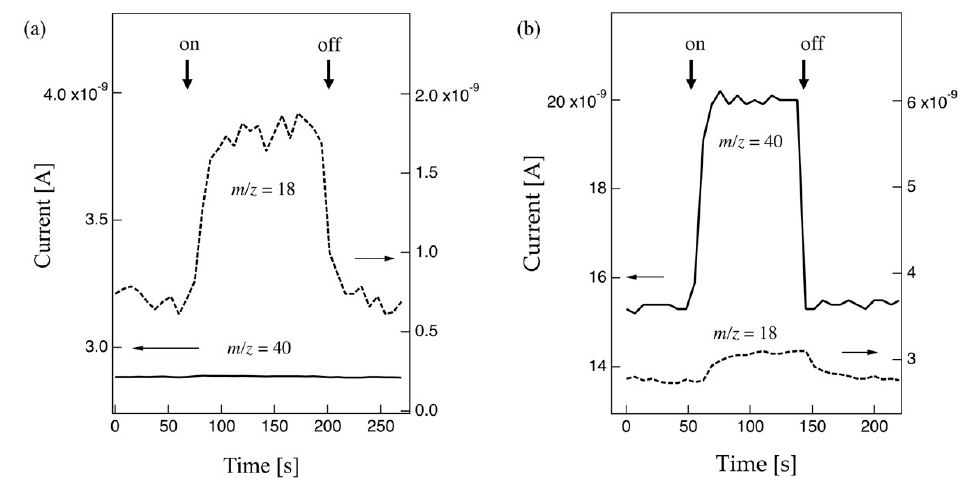
Figure 2. The background intensity of the m/z = 18 and 40 mass peaks in the sample chamber when the water cluster ion beams enter (on) and are shut off (off) by the deflector. Ar flow rates are 180 ( a ) and 280 ( b ) sccm. Data in ( a ) are taken from Ref. [15].